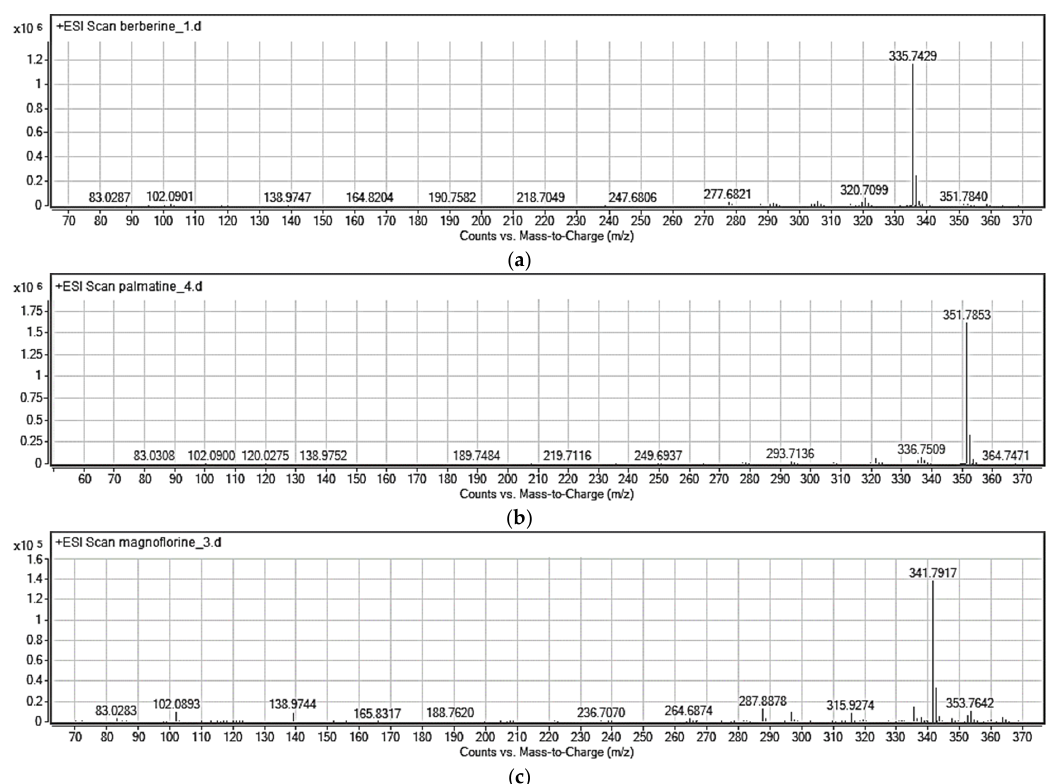
Figure 6. Representative MS spectra ( a – c ) for berberine (cortex), palmatine (root) and magnoflorine (cortex) obtained for studied isoquinoline alkaloids from Mahonia aquifolium extracts. Plant material collected during flowering. Experimental conditions: mobile phase composition: 70% v / v 0.1% HCOOH, 30% v / v MeCN, flow rate: 0.6 mL/min, autosampler temperature 20 ◦ C, drying gas flow rate 7.0 L/min; shielding gas flow rate 5.0 L/min; nebulizer gas pressure 40 psi; skimmer voltage 50 V, octopole voltage 800 V; capillary voltage 3500 V; drying gas temperature 295 ◦ C; shielding gas temperature 315 ◦ C; fragmentor voltage 195